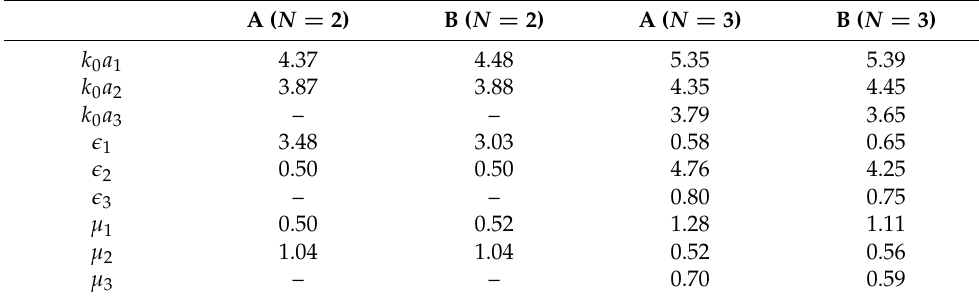
Table A3. Values of the optimization variables for optimized designs A and B of Figure 5.